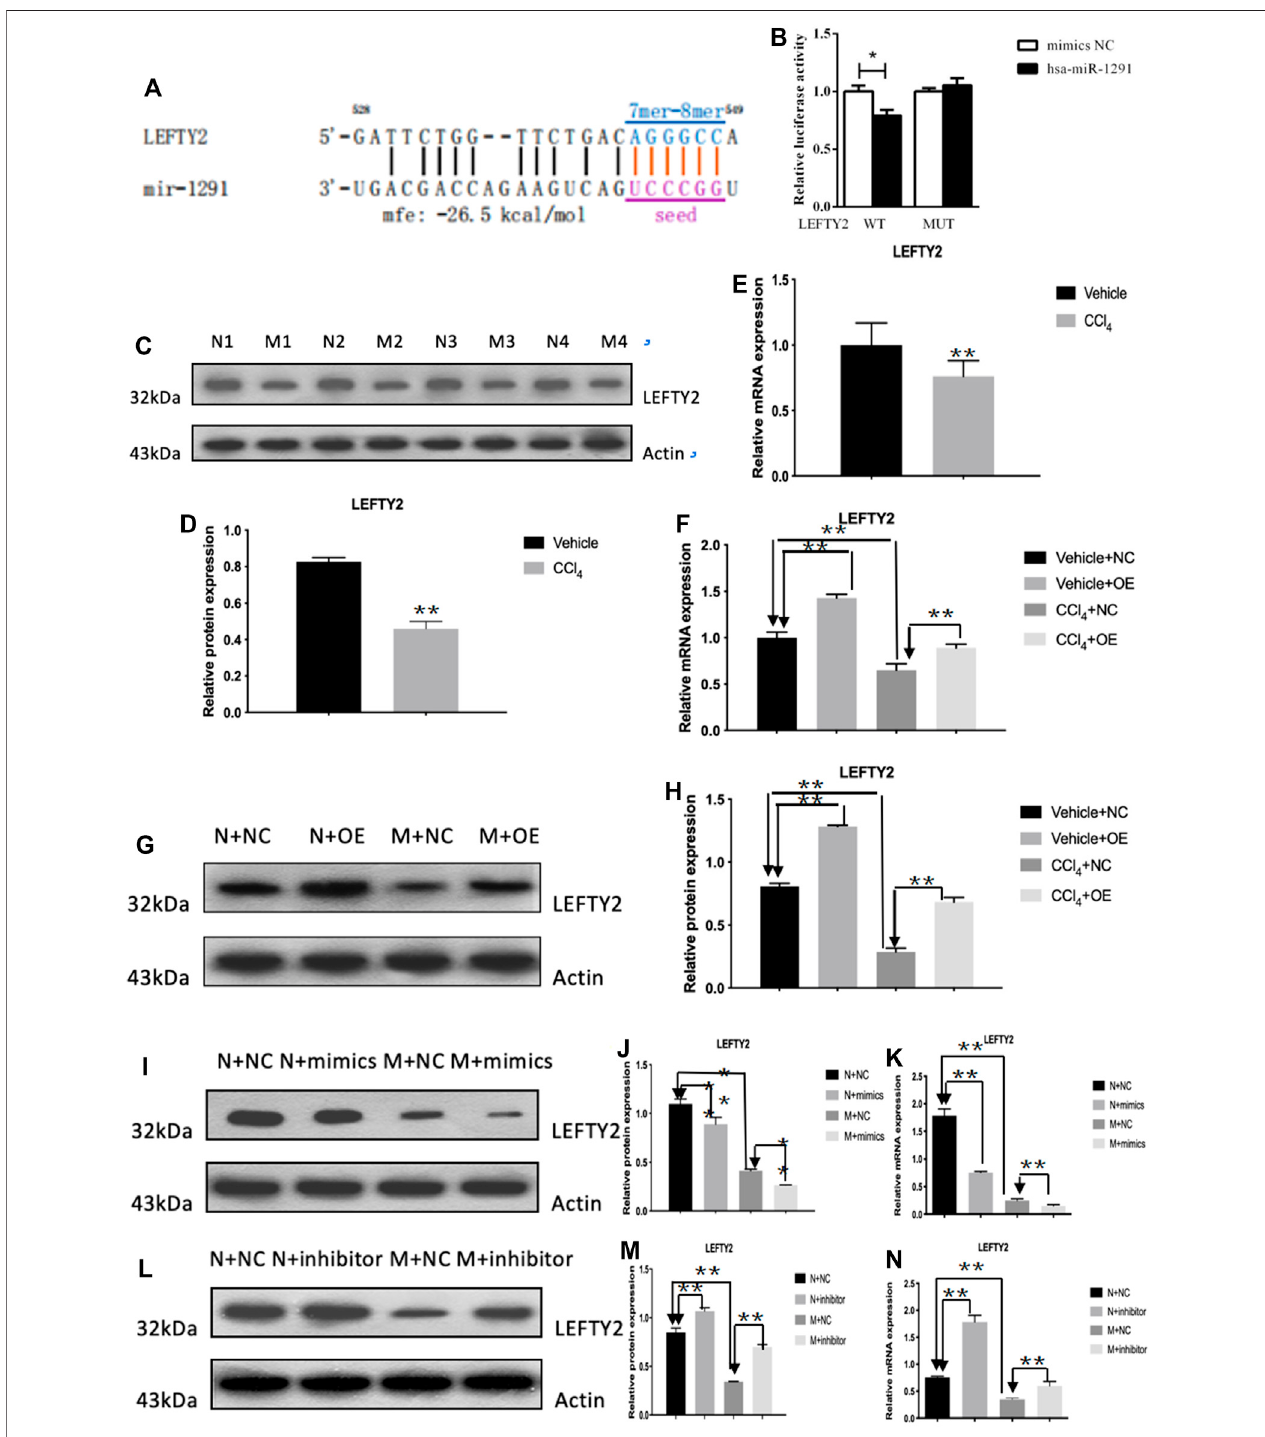
FIGURE 8 | LEFTY2 is one of the target genes of hsa-miR-1291 (A,B) . The expression level of LEFTY2 was down-regulated in HF mouse tissues (C – E) . The expression level of LEFTY2 was increased in AAV2/8-mmu_circ_0006288-treated HF mice (F – H) . When hsa-miRNA-1291 expression was increased or decreased, LEFTY2 expression level was down-regulated or up-regulated (I – N) .